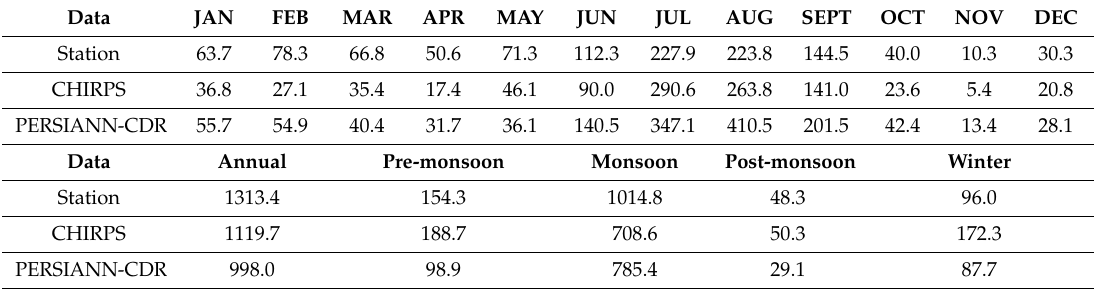
Figure 3. Mean distribution and variance of station-based and gridded rainfall products. Annual, seasonal ( a , c ), monthly ( b , d ) rainfall and variance, respectively for the period from 1983 to 2008. Table 2. Mean annual, seasonal, and monthly distribution of station and gridded datasets in the Bhilangana river basin for the period from 1983 to